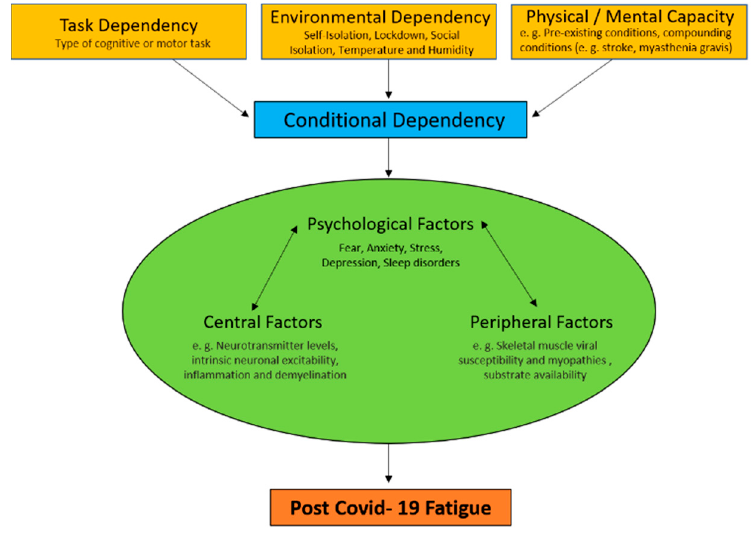
Figure 1. Fatigue is defined as the decrease in physical and/or mental performance that results from changes in central, psychological, and/or peripheral factors. These depend on the task being performed, the environmental conditions it is performed in, and the physical and mental capacity of the individual (conditional dependency). Importantly, fatigue is greatly affected by the factors of conditional dependency and the interactive changes in central, psychological, and/or peripheral factors (physiological factors) that cause